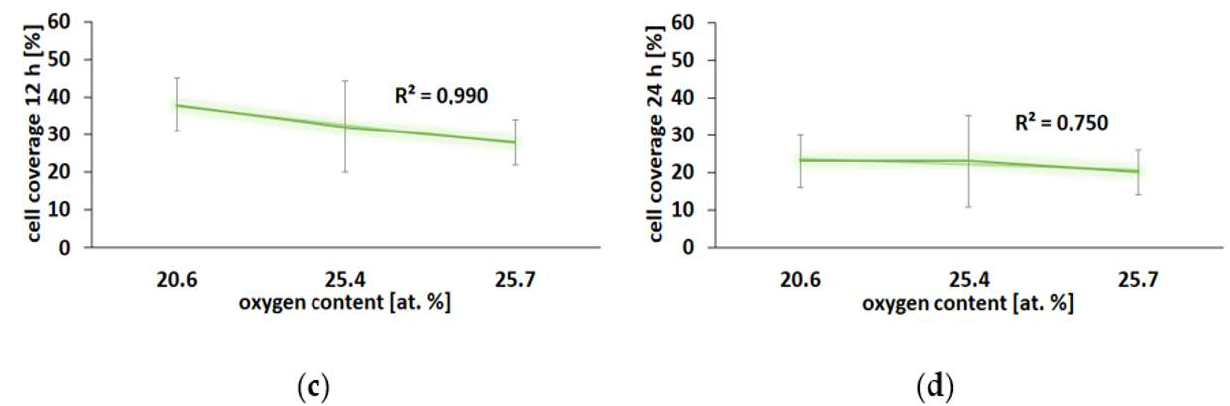
Figure 11. Cell adhesion to the analyzed surfaces as a function of nitrogen ( a , b ) and oxygen ( c , d ) content after 12 and 24 h of